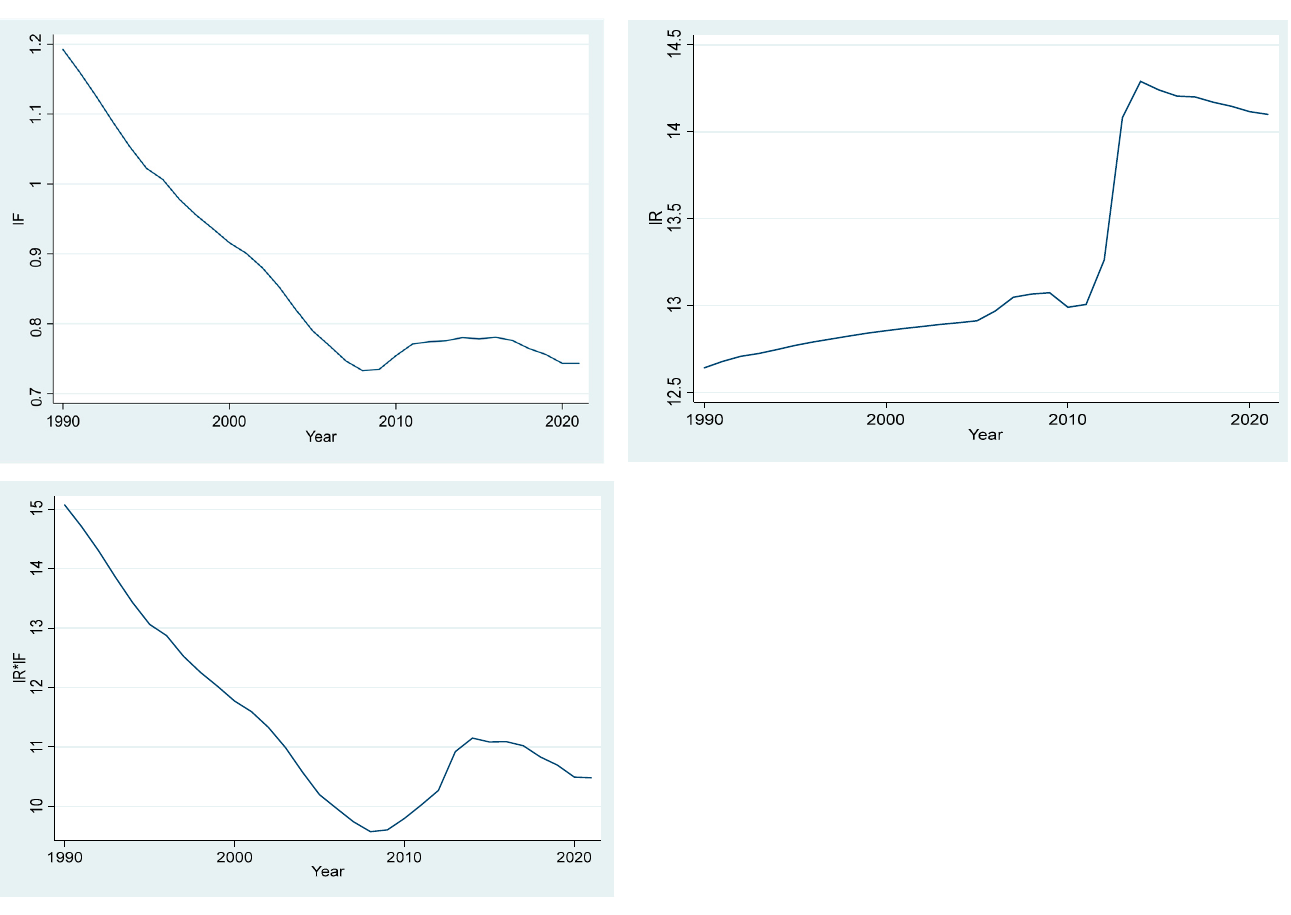
Figure A2. Time trend of variables for Lebanon.